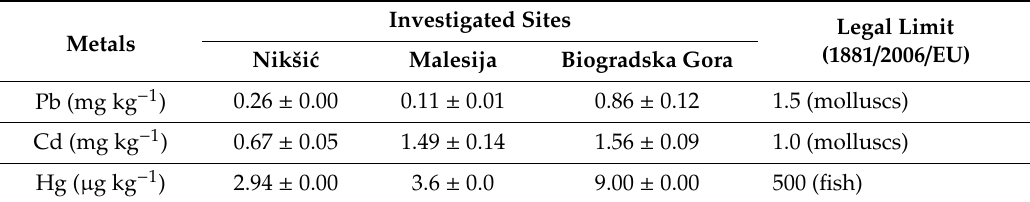
Table 7. Mean concentrations of metals in the studied snails from the three sampling sites of Montenegro and the legal limits (guidelines EU No 1881 / 2006), referred to as wet